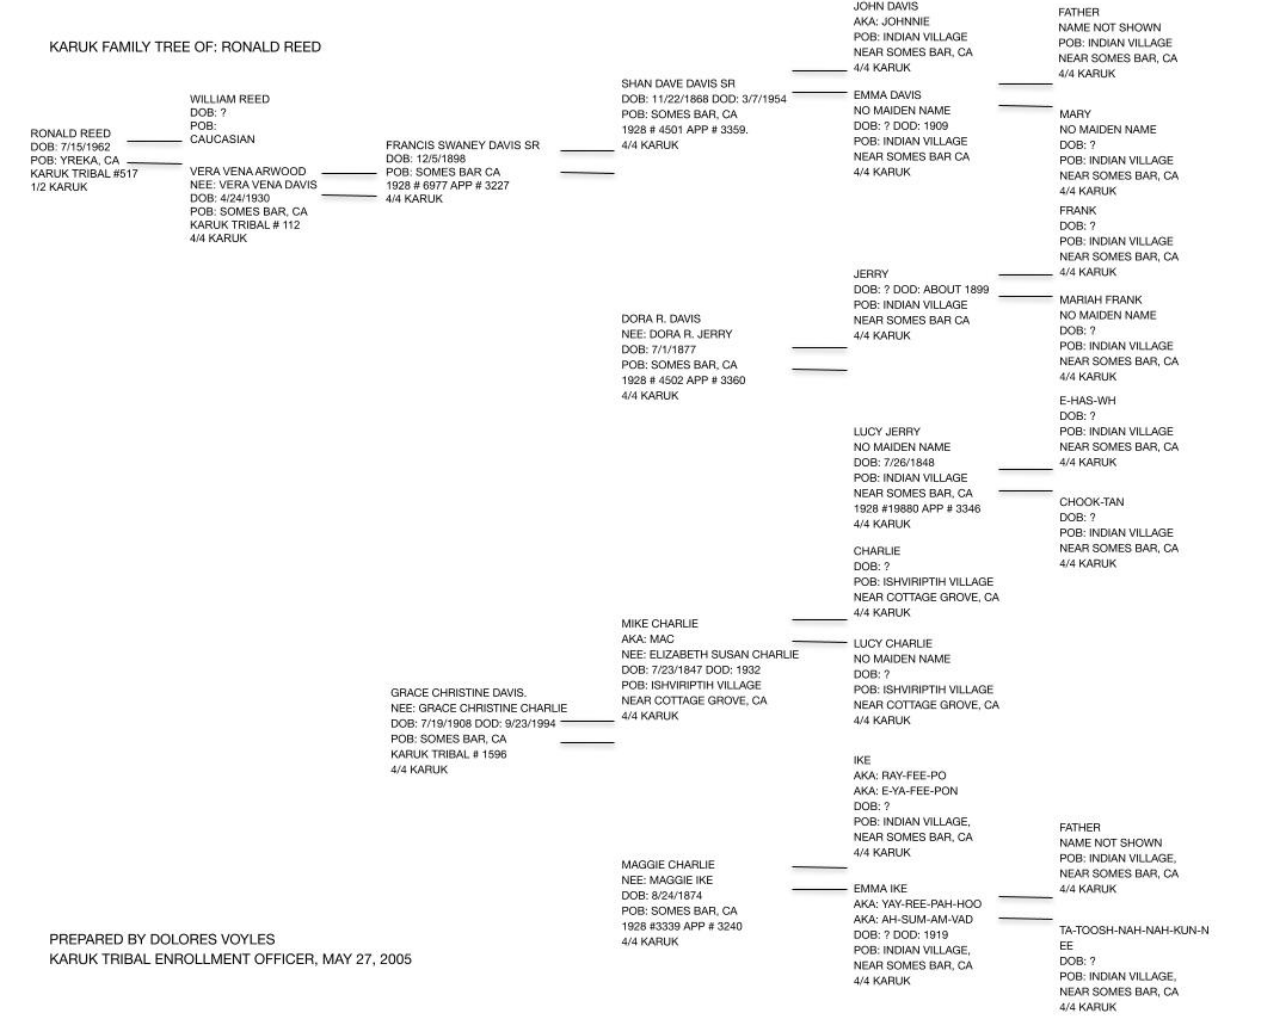
Fig. 2. Family tree for Ron